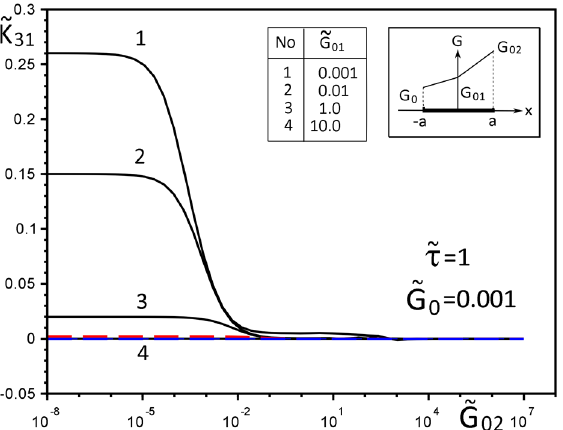
under the load, uniformly 31